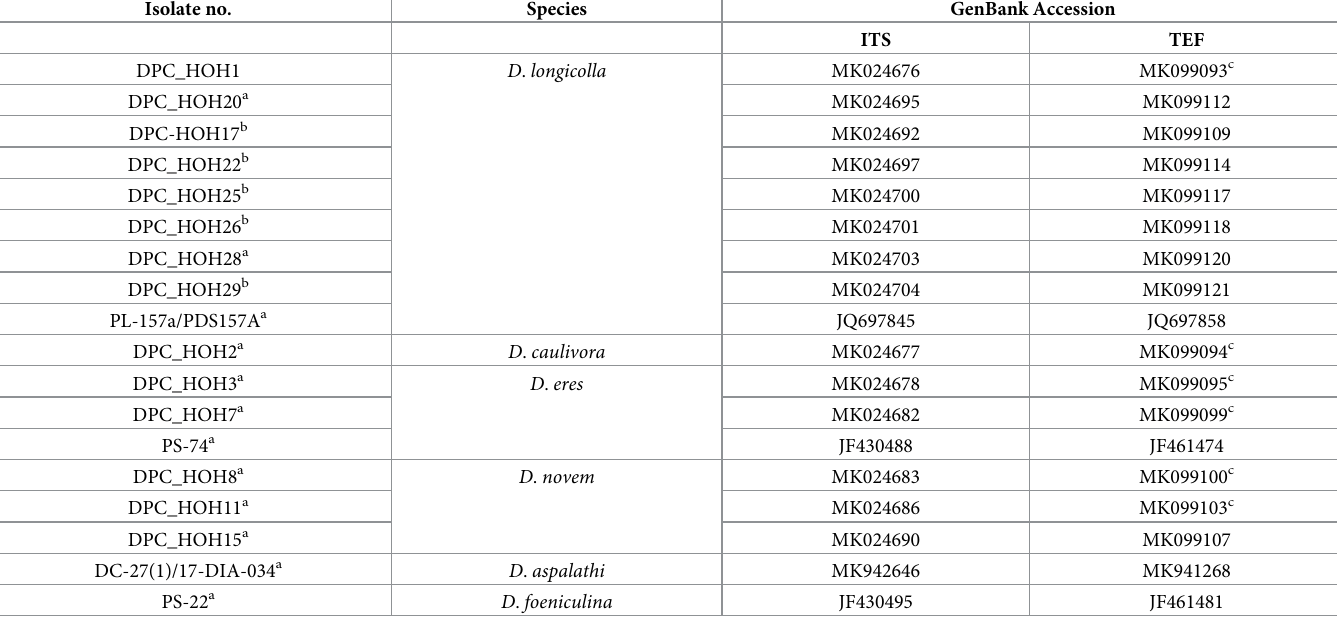
Table 1. Diaporthe strains used in this study and their corresponding GenBank accession numbers. Isolate no.